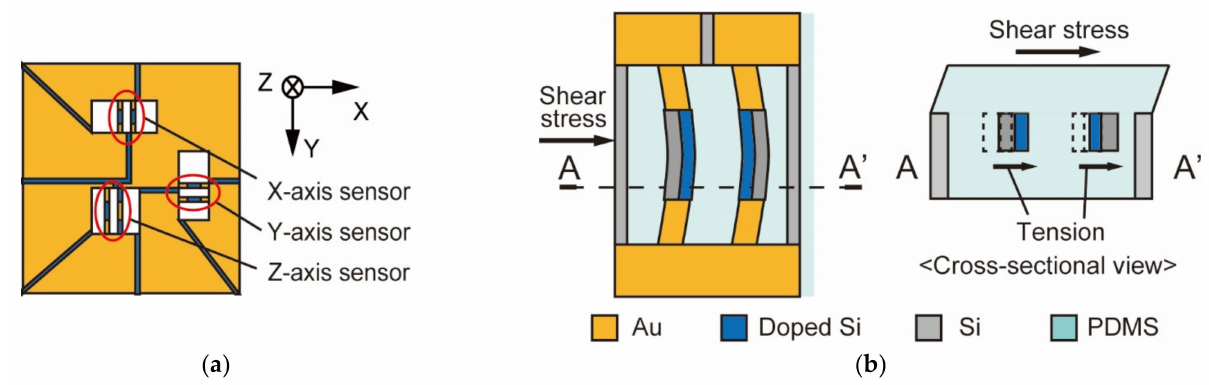
Figure 4. MEMS 3-axis force sensor: ( a ) Overview of the sensor; ( b ) The principle of the sensor.